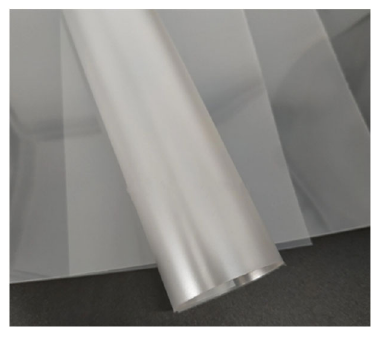
Figure 4. Matte canvas surface on sleeve.